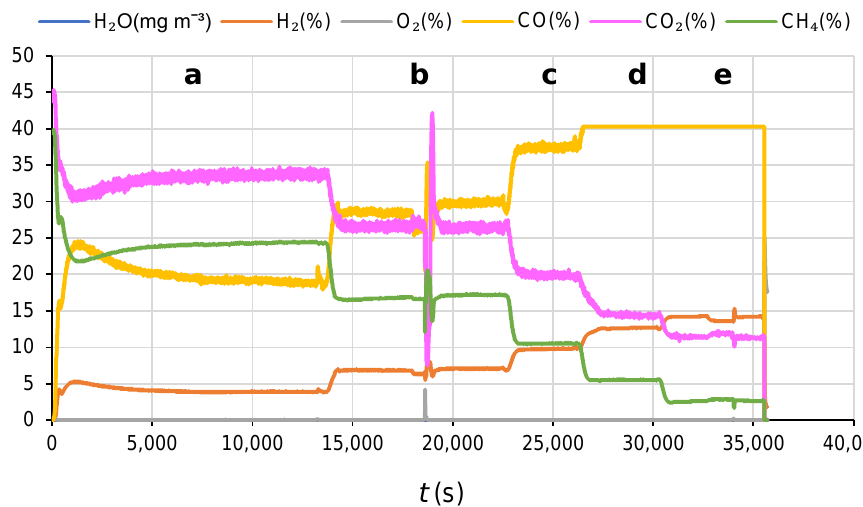
Figure 4. Concentration of ethanol steam reforming reaction products on retentate side of the membrane at different conditions: S/E = 2, ethanol feed concentration 27 vol.%, T = 500 ◦ C ( a ), 600 ◦ C ( b ), 700 ◦ C ( c ), 800 ◦ C ( d ), and 900 ◦ C ( e ).